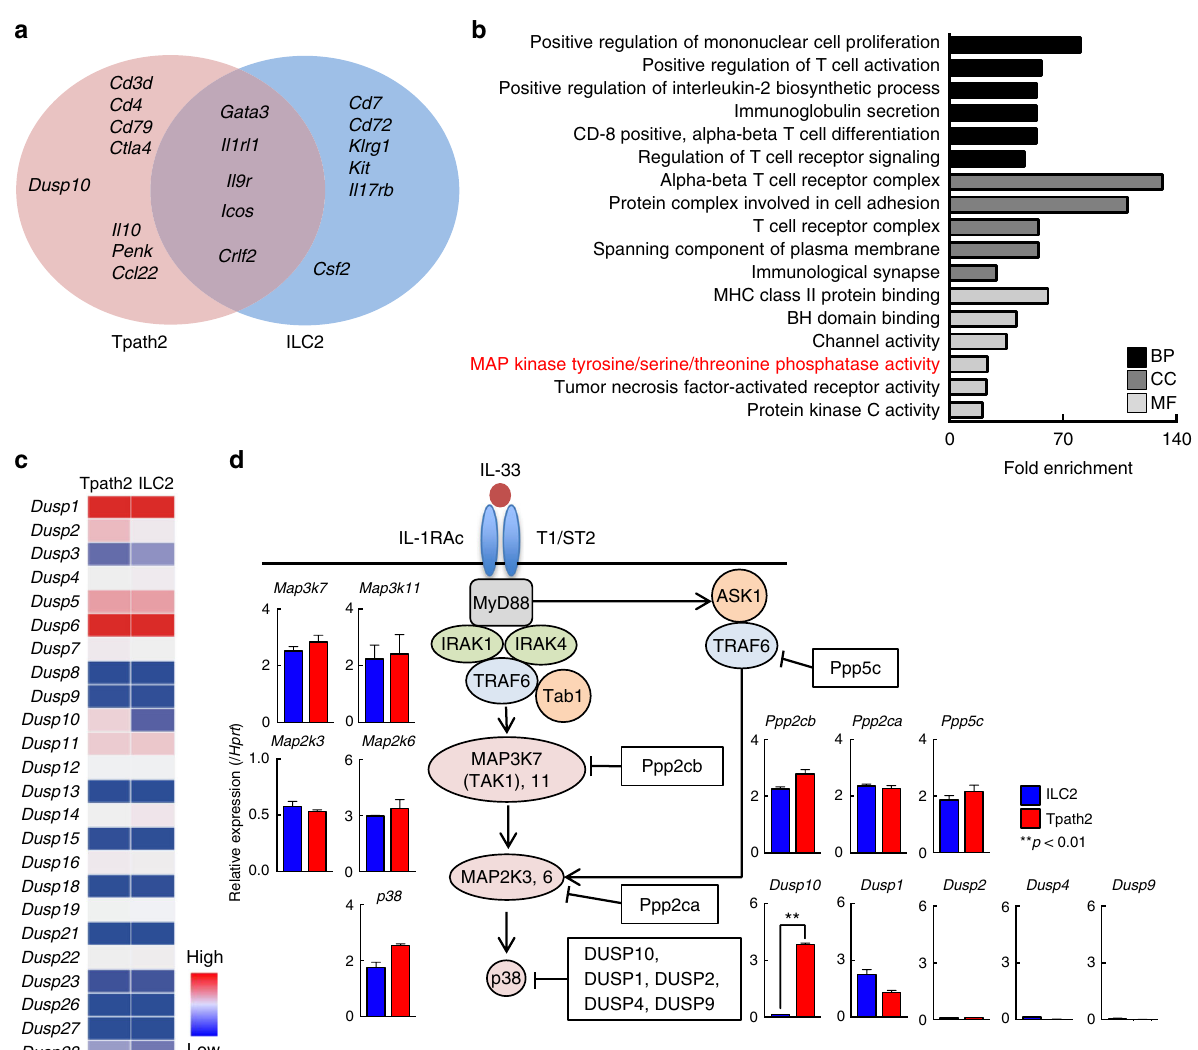
Fig. 2 Preferential expression of Dusp10 in Tpath2 cells. a – d Resting Tpath2 cells and ILC2s were used in RNA-sequencing. Cells isolated from spleens of memory Th2 mice (as shown in Supplementary Fig. 1a). After cultivation with IL-7, IL-25 plus IL-33 for 5 days, cells were rested with IL-7 alone for 24 h and analyzed by RNA-sequencing. a Venn diagram shows the genes preferentially expressed in Tpath2 cells and ILC2s. Immune response-related genes (GO0006955) preferentially expressed by unstimulated Tpath2 cells (Red) or unstimulated ILC2s (Blue) (>5-fold difference), or genes shared by the two (Purple) (<1.2-fold difference) are shown. Transcripts expressed above 10 fragments per kilobase of exon per million reads mapped (FPKM) are shown. b Gene Ontology analysis of genes that are expressed more highly in Tpath2 cells as compared to ILC2s. Graph shows folds change of indicated GO terms based on sub-categories including biological process (BP), cellular component (CC), and molecular function (MF) in Tpath2 cells to ILC2s (False discovery rate < 0.05). X -axis shows the number of fold-change ( p < 0.02, fold change of at least 10, BP biological process, CC cellular component, MF molecular function). Transcripts expressed above 10 FPKM in Tpath2 cells were used. c A heatmap of genes distinctly expressed between Tpath2 cells and ILC2s in pathway in Tpath2 cells and ILC2s. Two independent experiments were performed and showed similar results ( a – c ). More than three